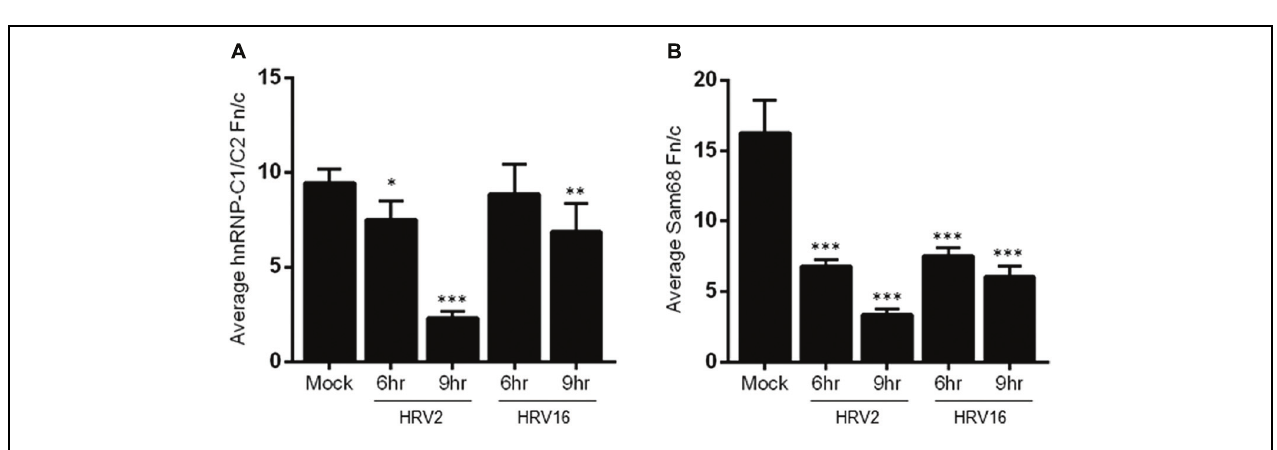
FIGURE 4 | Infection with HRV2 or HRV16 leads to significant mislocalization of nuclear proteins. The nuclear and cytoplasmic fluorescence of infected and mock infected cells prepared as in Figure 3 was